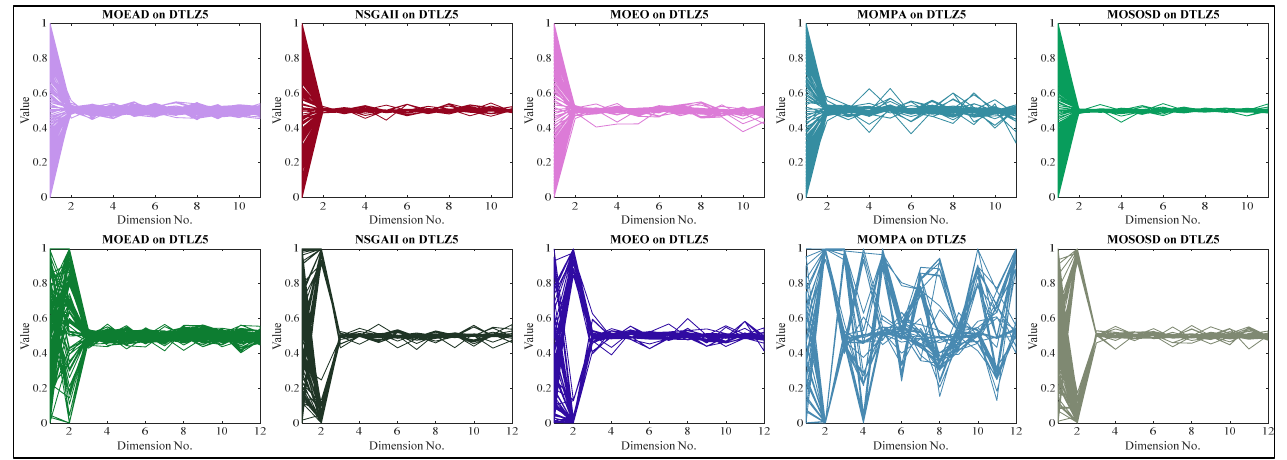
Figure 13. The dimension curve of MOEA/D, NSGA-II, MOEO, MOMPA, and MOSOS/D for DTLZ5 at 𝑀 = 2, 3 .